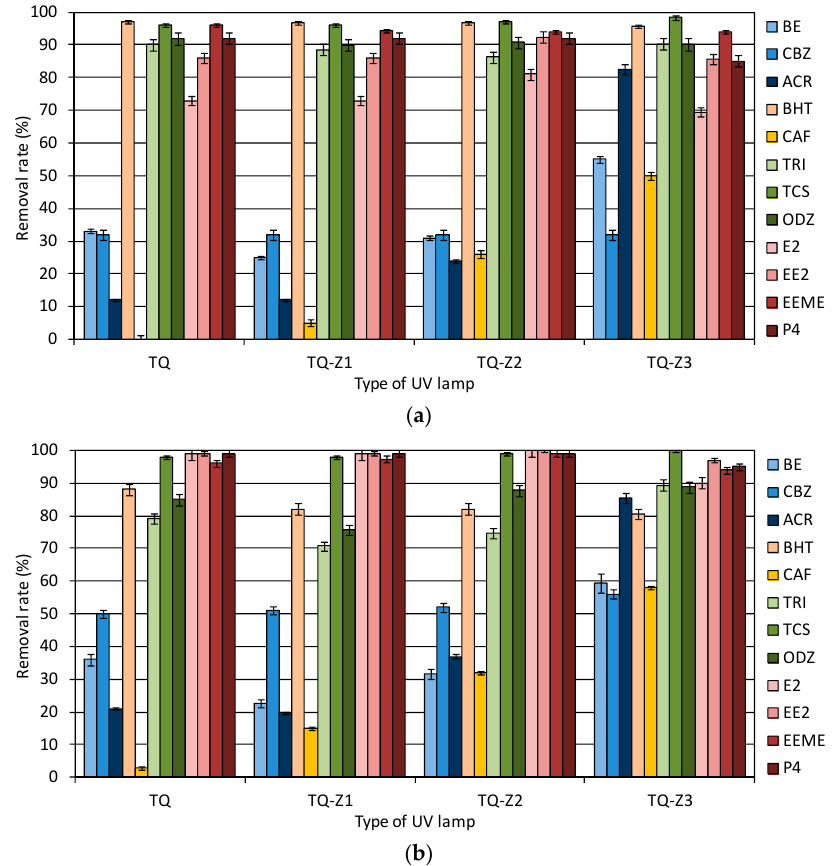
Figure 2. Decomposition of compounds after 60 min of ( a ) photolysis and ( b ) photocatalysis